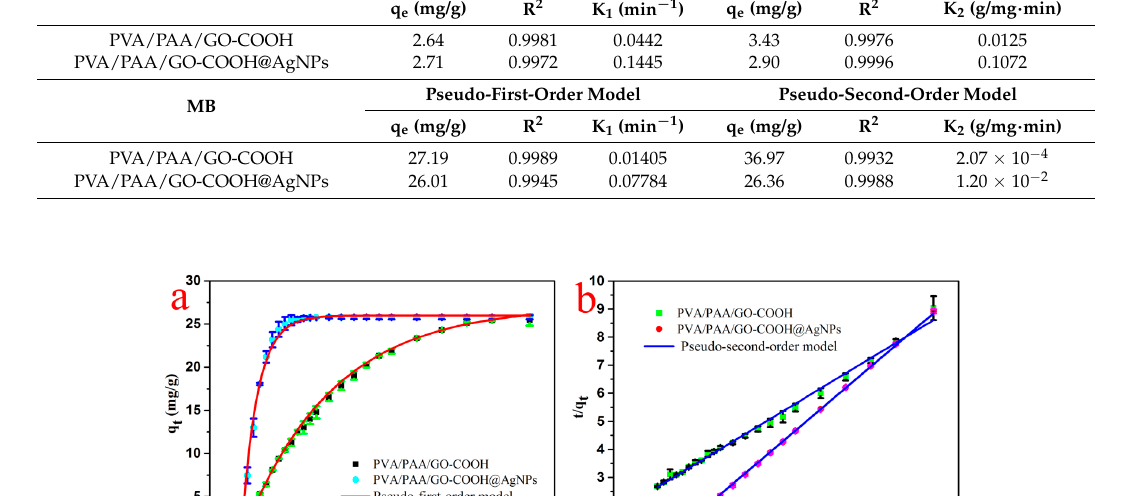
Table 1. Kinetic parameters of PVA/PAA/GO-COOH nanocomposite and PVA/PAA/GO-COOH@AgNPs nanocomposite for RhB and MB degradations and removal at 298 K (experimental data from Figure 7). RhB